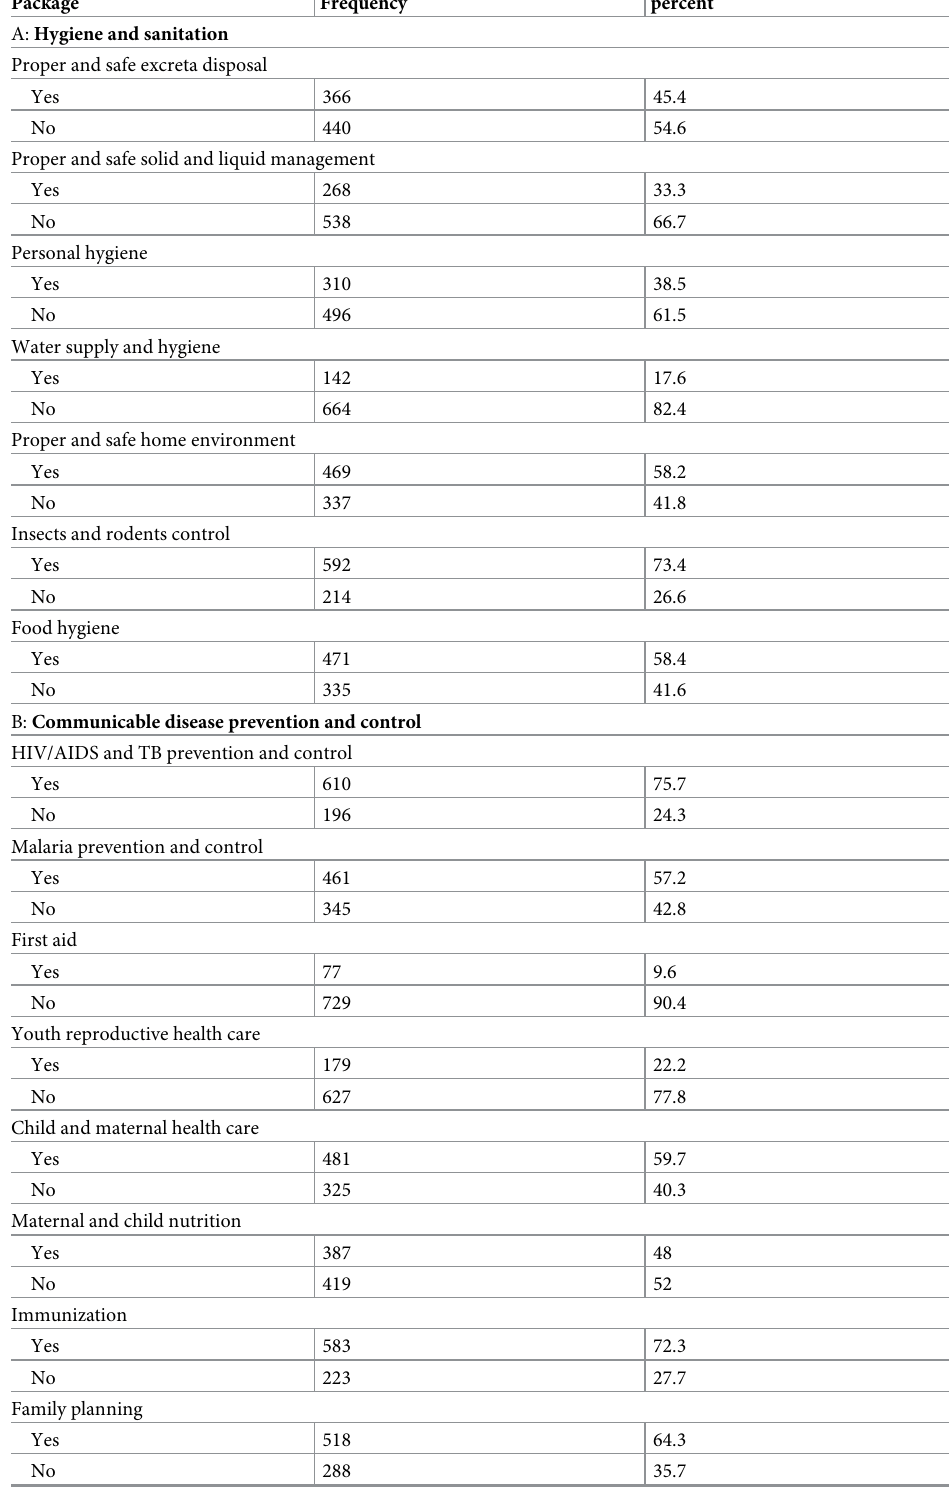
Table 3. Utilization of health extension package (n = 806) in East Gojjam Zone, Northwest Ethiopia,